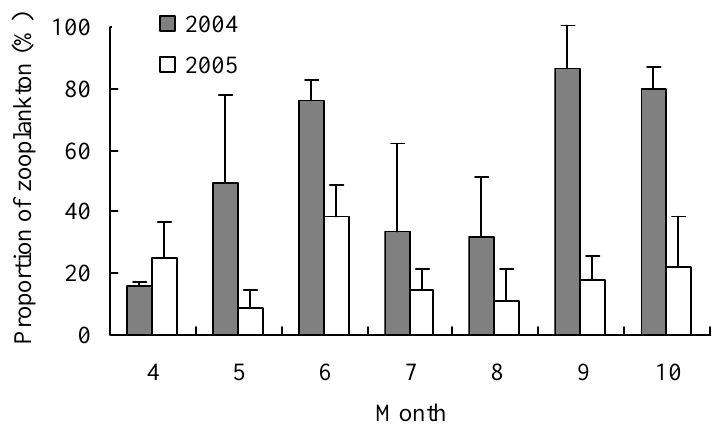
FIGURE 2 . Comparison of zooplankton proportion in the gut contents of silver carp from April to October in 2004 and 2005. Error bars represent 1 S.D.